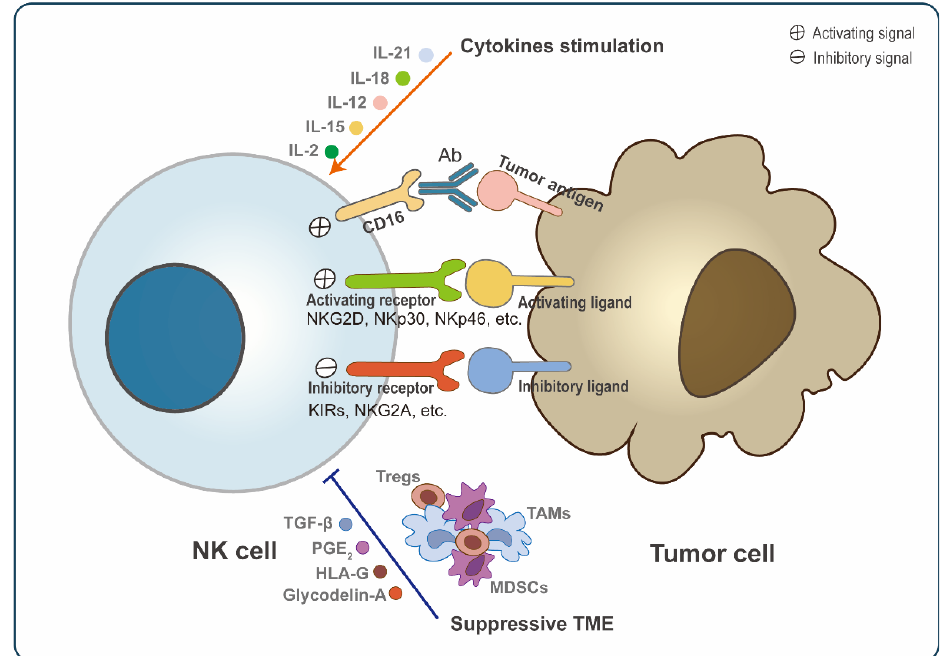
Figure 1. General regulation of NK cell activation . Natural killer (NK) cell activation is a dynamic process mediated by multiple factors. NK cells express a range of receptors, including